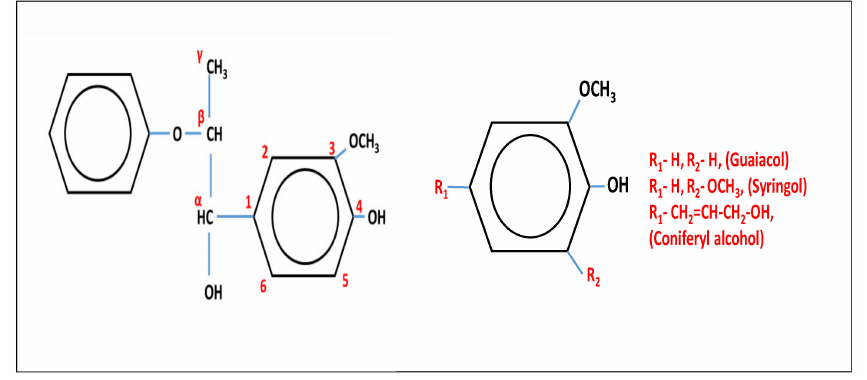
Figure 1. Basic structures and the standard numbering system used for molecules associated with lignin.